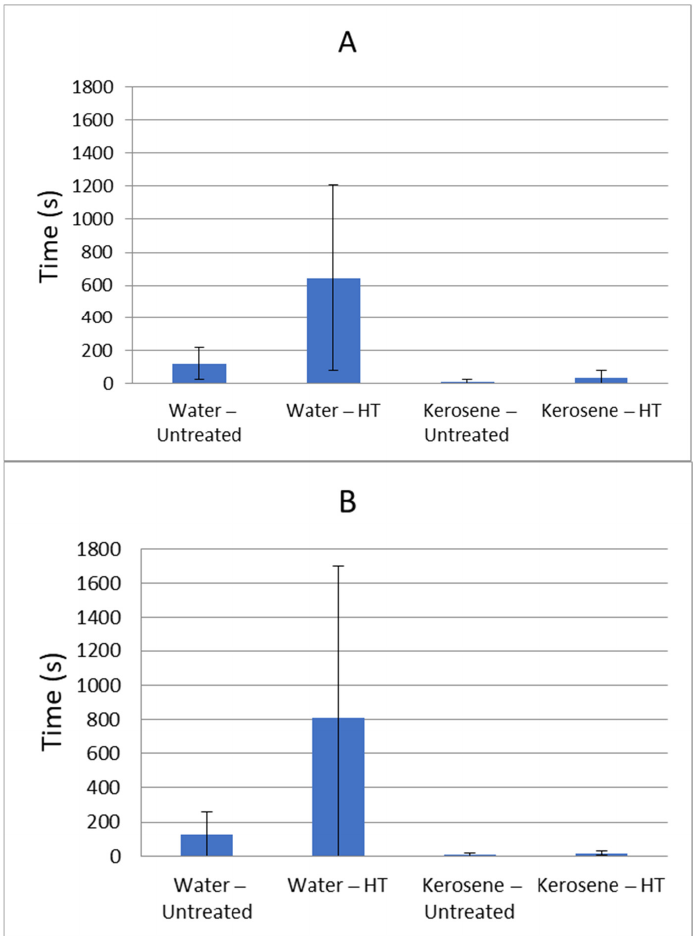
Figure 3. Liquid permeability, as determined by the first drop from the bottom of the specimens, in Populus nigra var. betulifolia with 3 × 4 m spacing ( A ) and 3 × 8 m spacing ( B ) (HT = heat-treated).